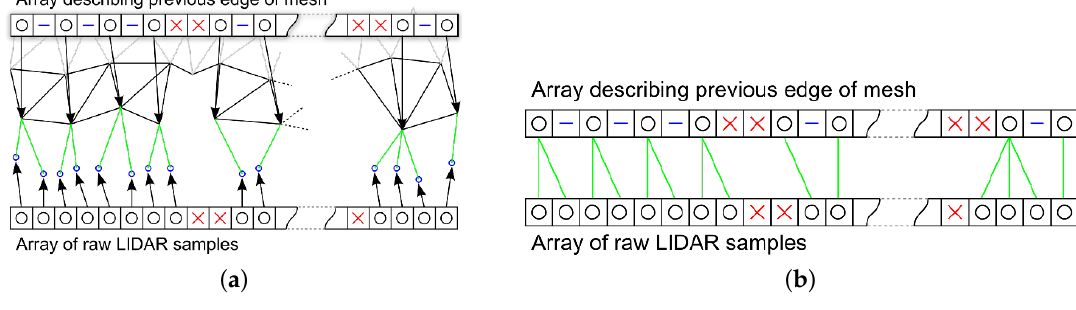
Figure 16. Calculating the mean Cartesian distance between lines ( a ); and between array elements ( b